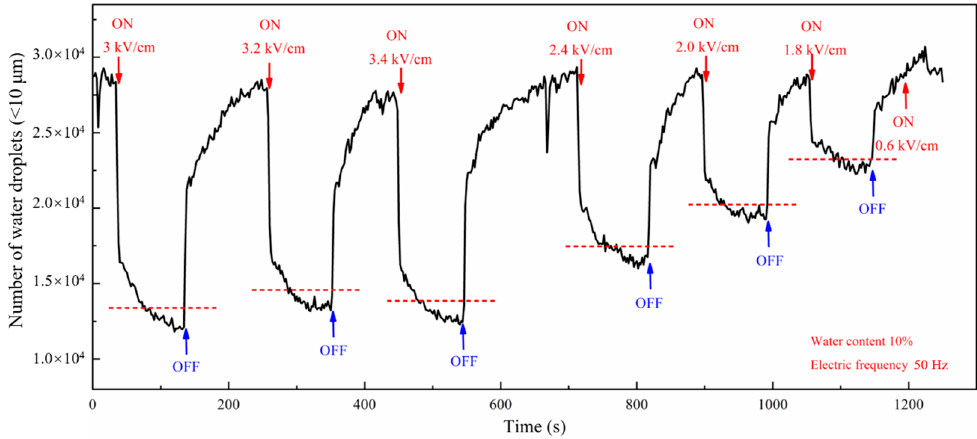
Figure 16. Variations of water droplets number within 10 μ m (water content 10%).